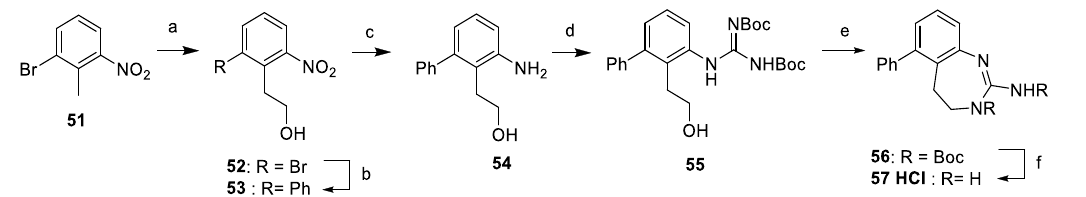
Scheme 7. Synthesis of 6-phenyldihydrobenzodiazepine 57 . Reaction conditions : (a) CH 2 O, Triton B, DMSO, 90 °C, 16 h,